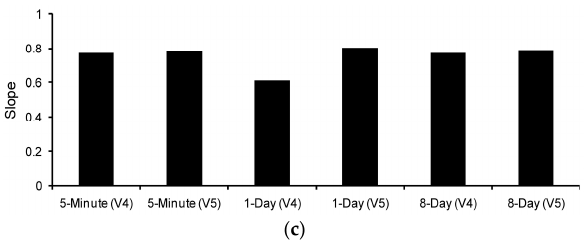
Figure 3. Relationship between MODIS/Terra land surface temperature products versus the aggregated observation of Landsat 7 ETM+ land surface temperature at 960 m resolutions for the urban mask. ( a ) coefficient of determination (R 2 ); ( b ) root mean square error (RMSE); and ( c ) slope of regression relationship.